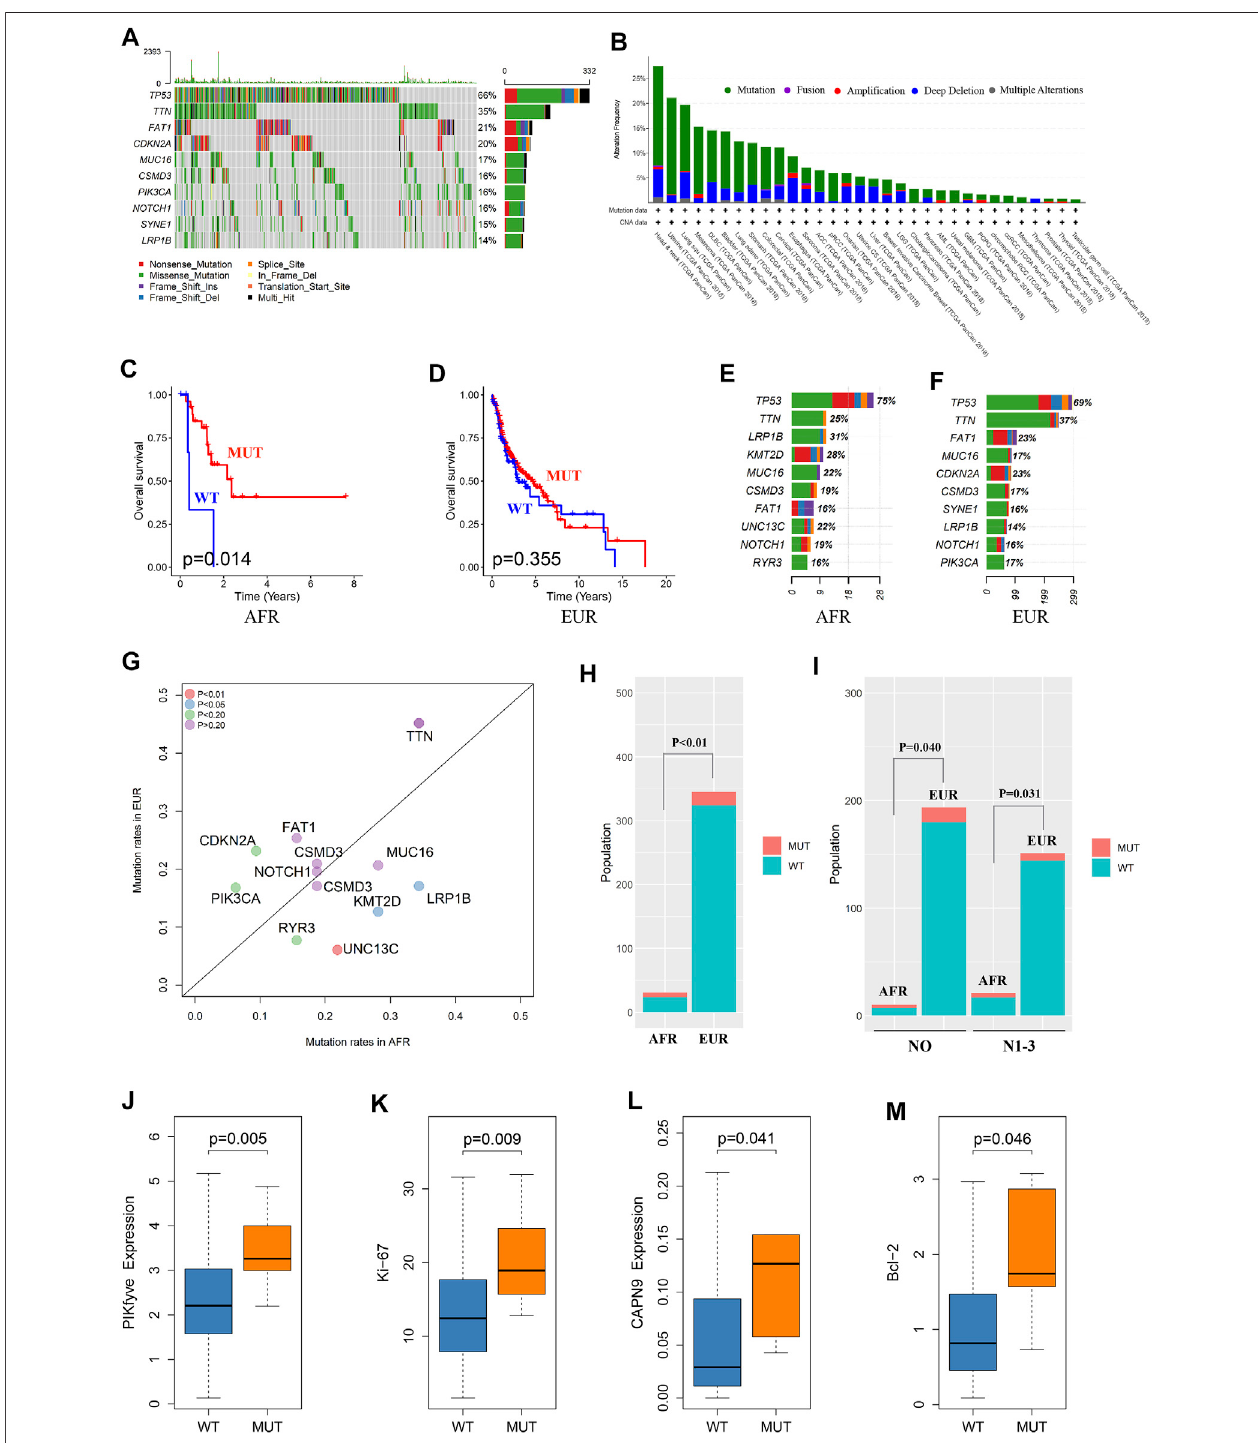
FIGURE 3 | Somatic mutation differences between EUR and AFR OSCC patients. (A) Waterfall plots of the genes with the top 10 single-nucleotide variant frequencies among all OSCC patients in the TCGA database. (B) The pancancer mutation frequency of FAT1 , which shows that the mutation frequency was highest in head and neck squamous cell carcinoma. (C) The survival of the FAT1 -mutated patients was signi fi cantly better than that of the wild-type patients in the AFR ancestry. (D) No signi fi cant difference in survival was found between FAT1 -mutated and wild-type patients in the EUR ancestry. (E) The genes with the top 10 mutation